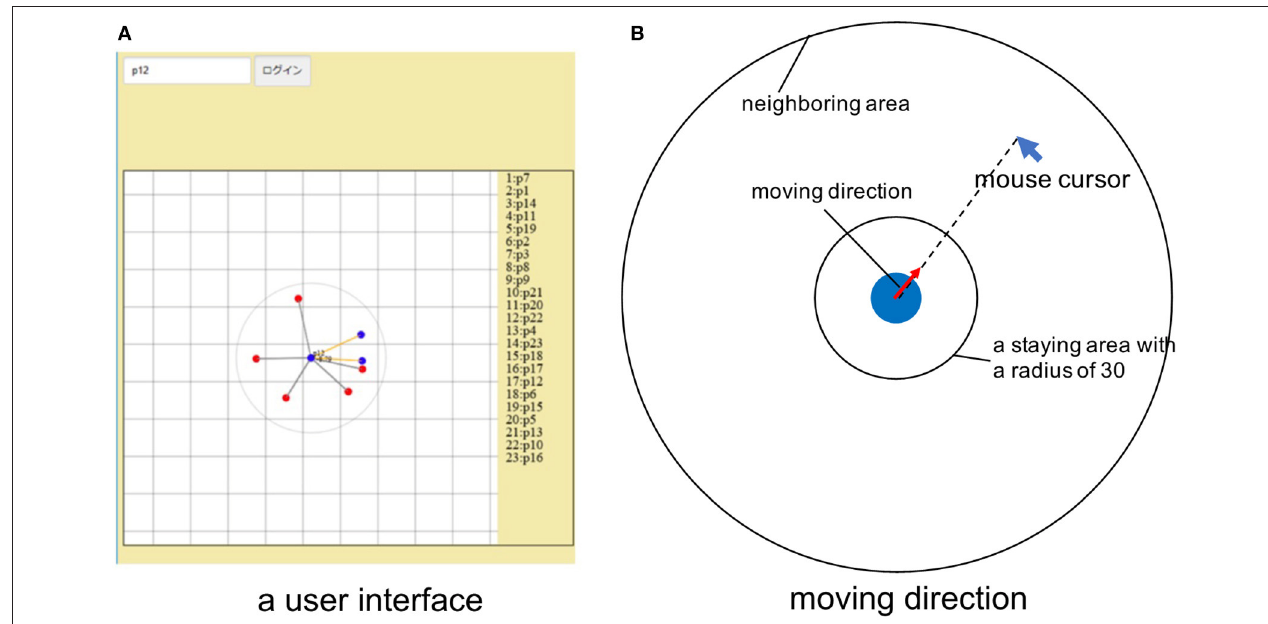
FIGURE 1 | (A) A screenshot of a web-based user interface. A player is located at the center of the panel, and her neighbors within the range of R = 100 were shown. The color of each point represents her strategy (blue: cooperation, red: defection). The color and the thickness of the link reflects the payoff from a neighbor to the focal player. (B) The moving direction of a player. A player moves toward the direction of the mouse cursor with a speed V (pixel/step) if the cursor is outside of the staying area.